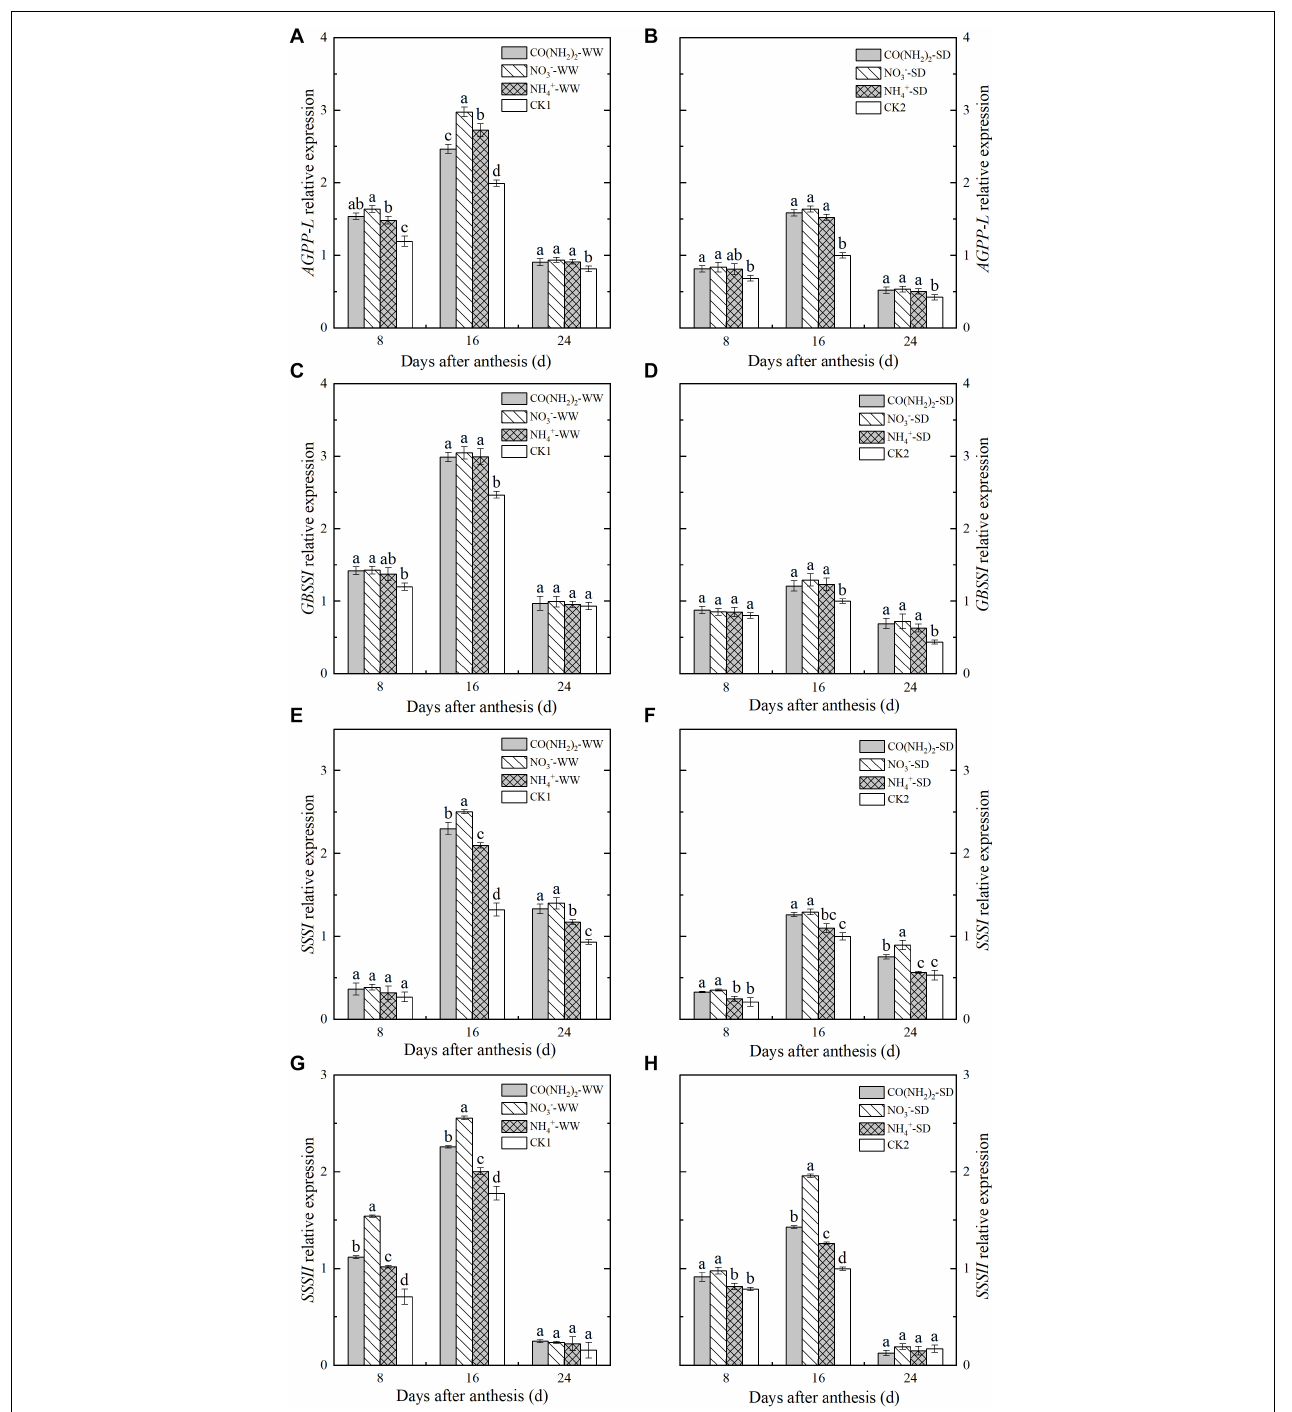
FIGURE 5 | Effect of N forms in foliar fertilizer on the relative expression of AGPPL, GBSSI, SSSI , and SSSII enzyme genes in the wheat grains [ (A,C,E,G) well-watered treatment, WW; (B,D,F,H) soil-dried treatment, SD]. Vertical bars represent ± the standard deviation of the mean ( n = 3). CO(NH 2 ) 2 , NO 3 − , and NH 4 + represent CO(NH 2 ) 2 , NaNO 3 , and NH 4 Cl, whose concentration was described in the Materials and Methods section. CK1 and CK2 mean that deionized water was sprayed on leaves at anthesis under well-watered treatment and soil-dried treatment, respectively. Values followed by the same letters in each soil moisture are not significantly different at P < 0.05